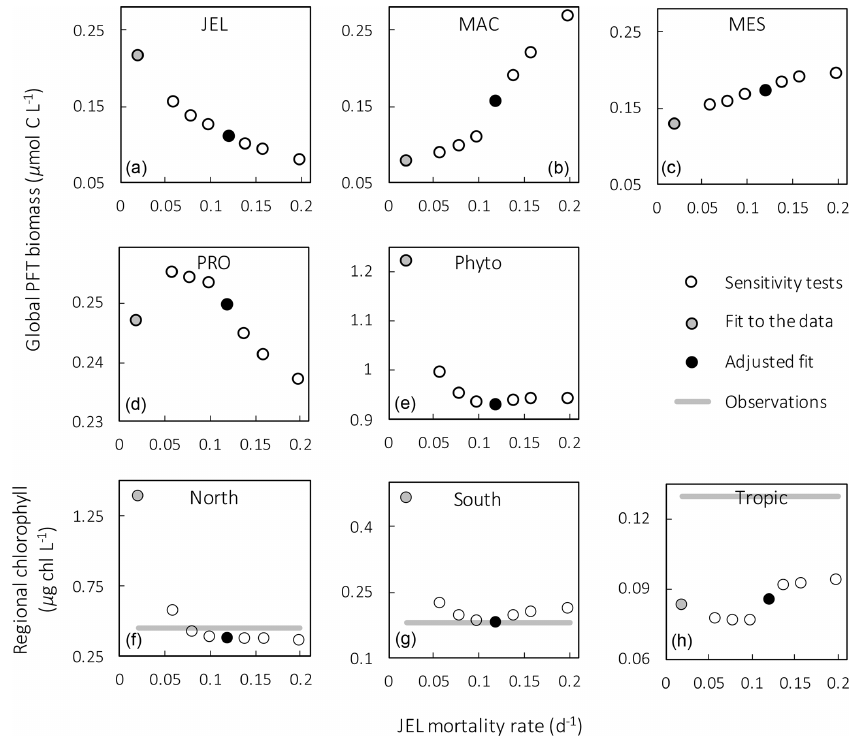
Figure 4. Results from sensitivity tests on jellyfish mortality rates. The adjusted fit simulation used for PlankTOM11 is shown by the black filled circle, and the fit to the data simulation is shown by the grey filled circle; global mean PFT biomass (µmolCL − 1 ) for 0–200m depth (a–e) and regional mean surface chlorophyll concentration (µgchlL − 1 ; f–h ) are shown. For the regional mean chlorophyll, the observations are calculated from SeaWiFS. All data are averaged for 1985–2015, and between 30 and 55 ◦ latitude in both hemispheres: 140–240 ◦ E in the north and 140–290 ◦ E in the south (see Fig. 8). “Phyto” is the sum of all the phytoplankton